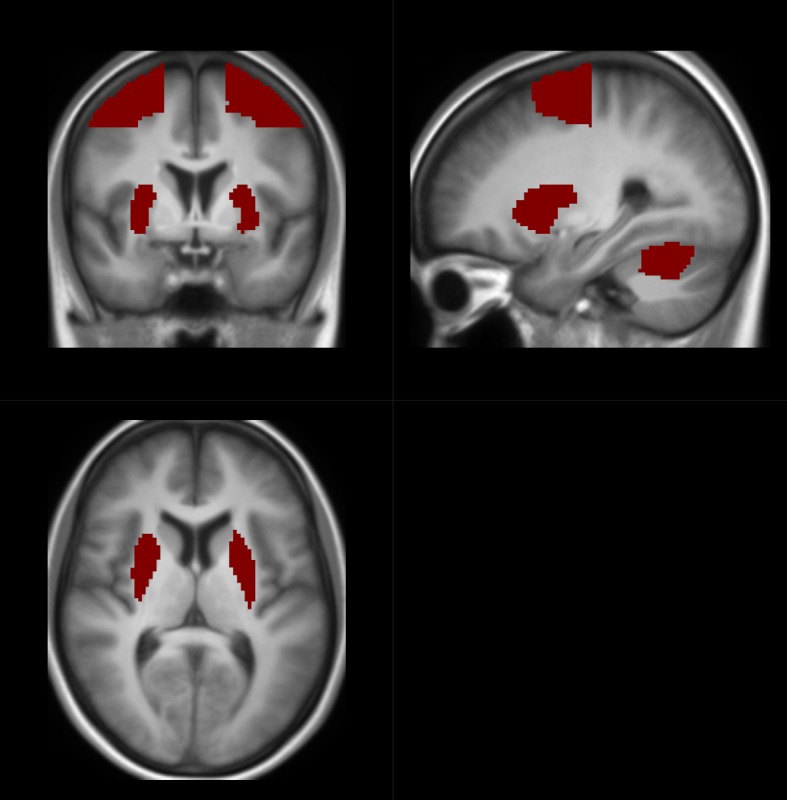
The mask used to define the region of interest.A single mask consisting of the cerebellum lobule VI, putamen, and PMd of both hemispheres were used to define the region of interest.